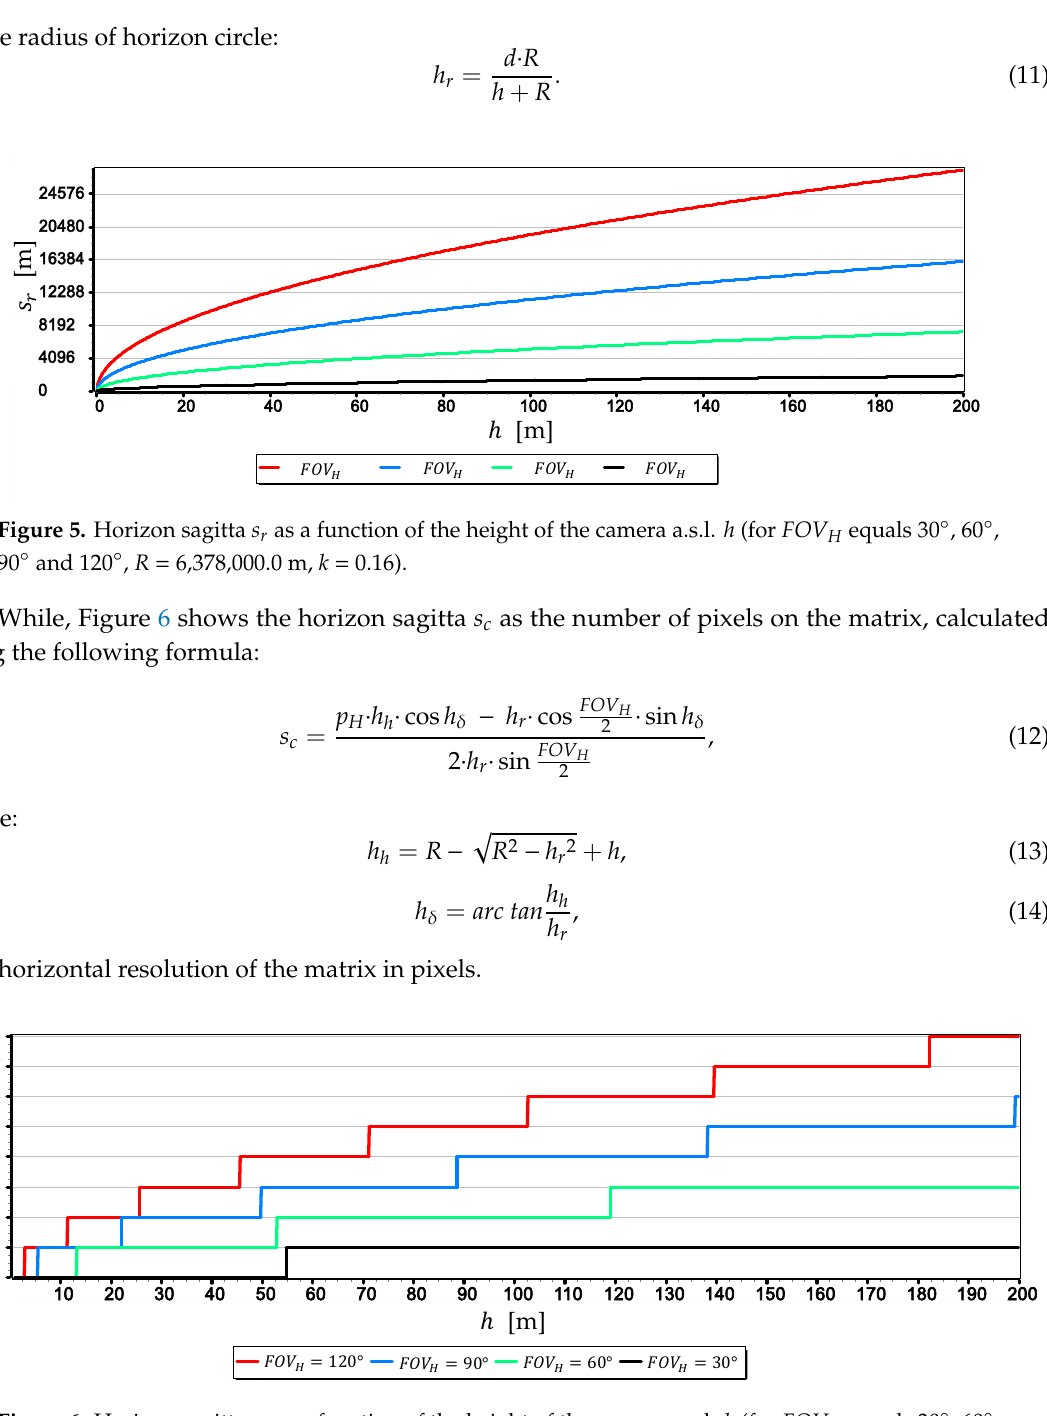
Table 1. Technical parameters of evaluated UAV cameras. Type of Camera and Gimbal Optical Parameters Camera: DJI FC350 Gimbal: Zenmuse X3